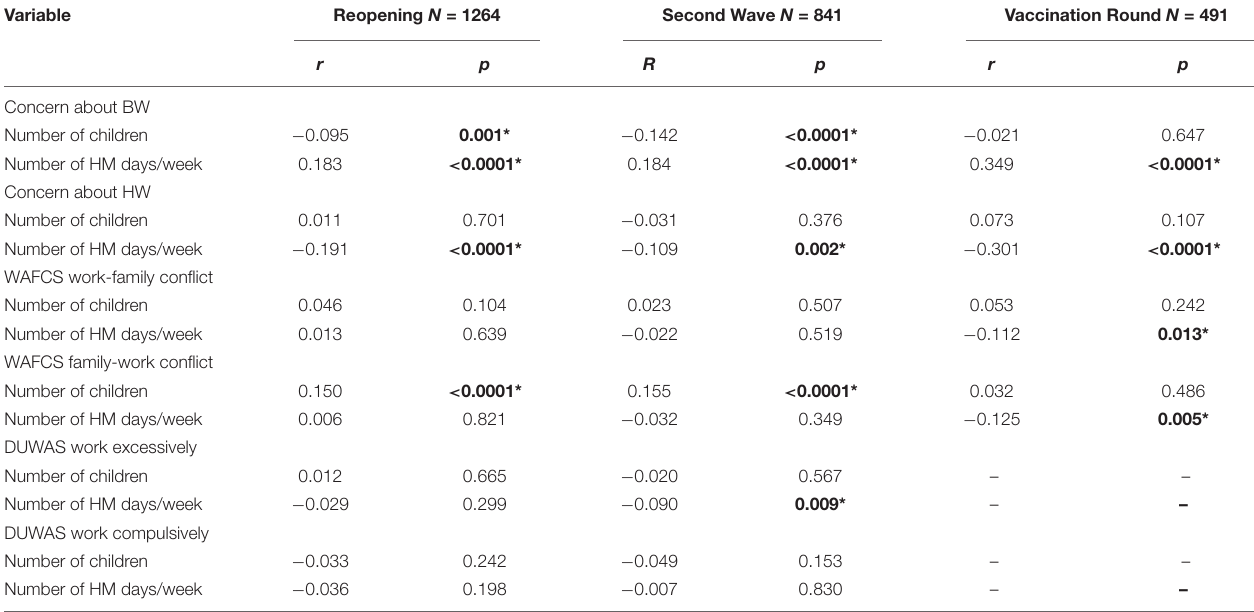
TABLE 7 | Demographic correlates of Concern about BW and HW, WAFC, and DUWAS in the three